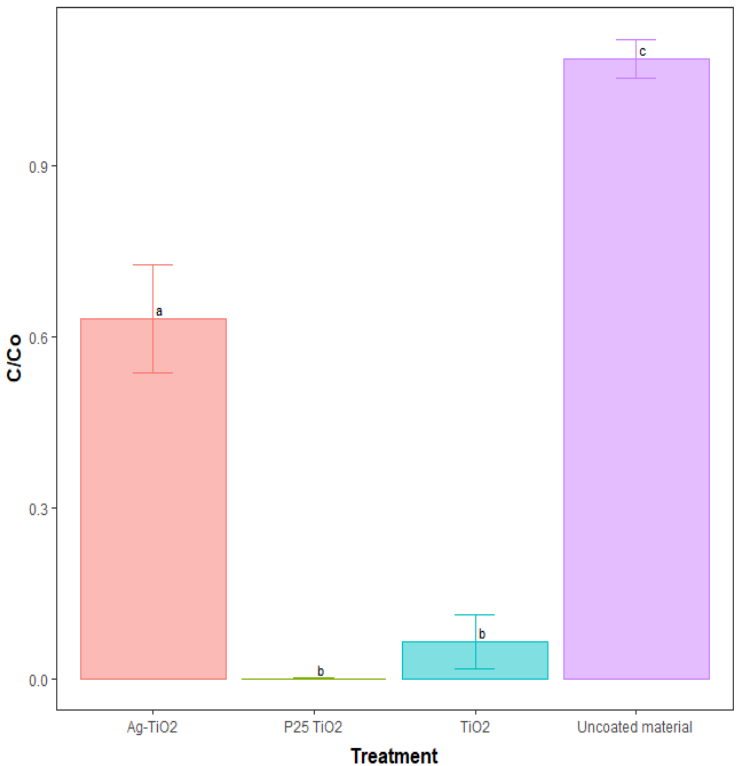
Figure 4. Remaining concentration of methylene blue (MB) after 6 h for each treatment (Ag-TiO 2 , P25 TiO 2 , TiO 2 , uncoated material). Error bars each represent ± standard deviation of four measurements (n = 4). Treatments with the same letter are not significantly different ( p > 0.05).